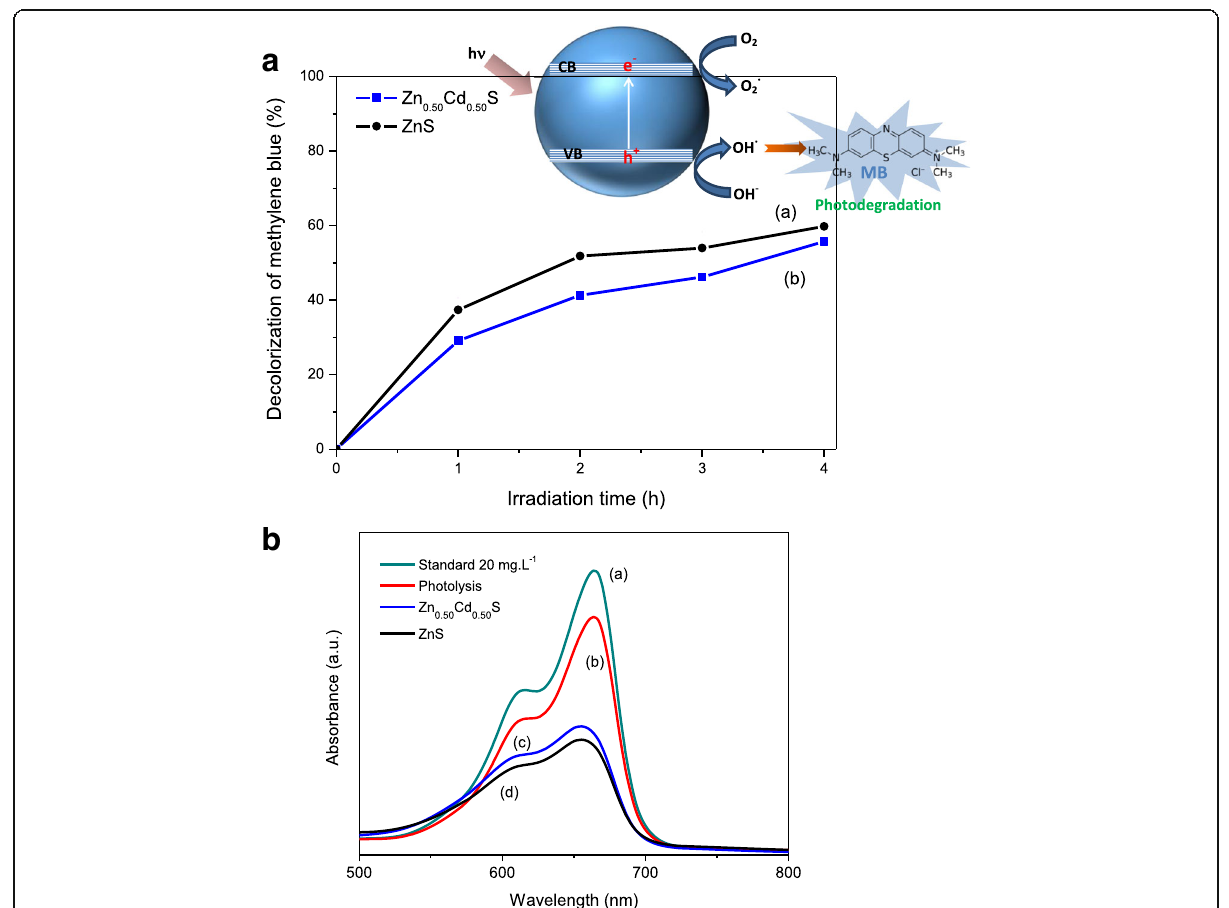
Fig. 10 Photocatalysis application of conjugates. a Decolorization of methylene blue (MB) in aqueous solution by nanophotocatalyst ZnS (a) and Zn 0.50 Cd 0.50 S (b). Inset drawing : schematic organic dye degradation by conjugates. b Absorption spectra of MB aqueous solution: reference solution (a) and degraded by light (control) (b) , Zn 0.50 Cd 0.50 S (c) and ZnS (d) conjugates under UV light after 4